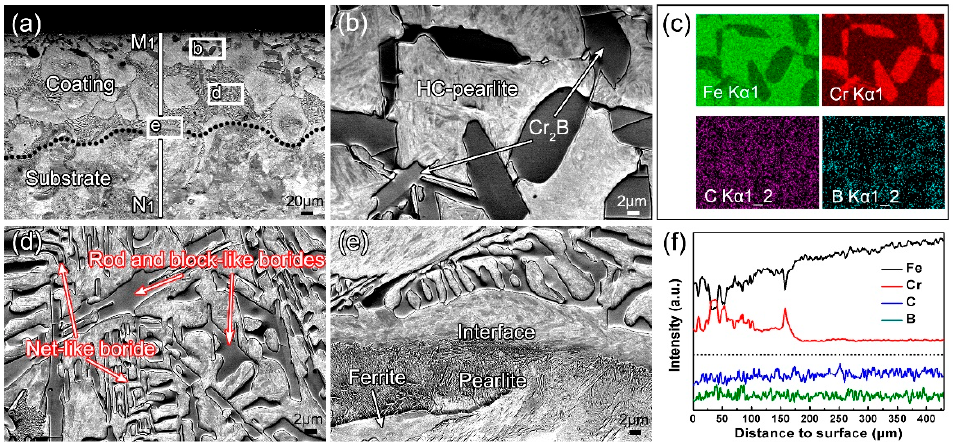
Figure 4. Microstructure and element distribution of the BCr-30 sample: ( a ) BSEI image of the coating; ( b ) ( d ) ( e ) high magnification BSEI images corresponding to the white boxes in ( a ); ( c ) EDS area scanning in ( b ); ( f ) EDS line scanning in ( a ) (M 1 to N 1